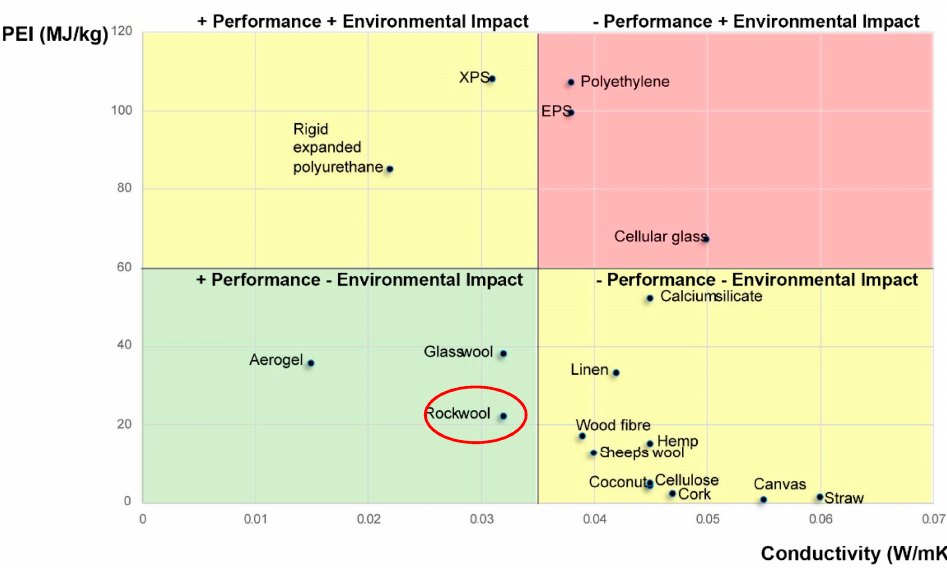
Figure 6. Comparison of environmental impact and performance of insulating materials.